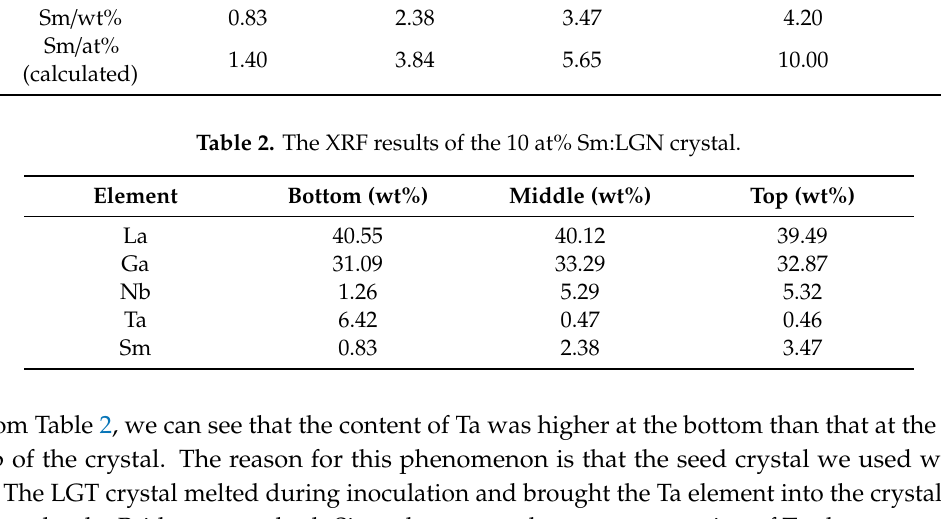
Table 1. The XRF results of Sm in 10 at% Sm:LGN crystal.